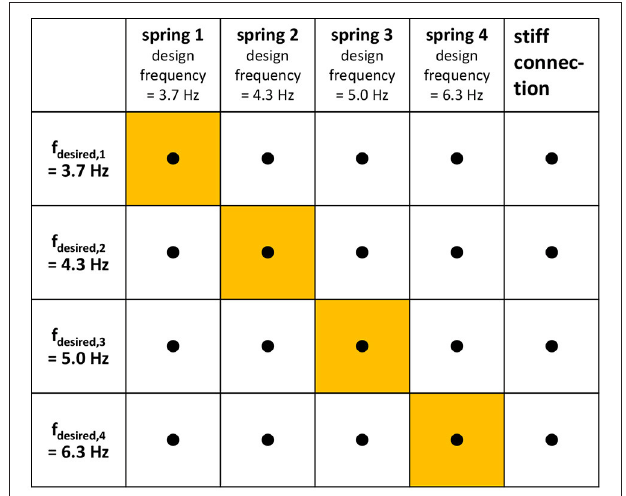
FIGURE 2 | Trials— Combination matrix of the factors “desired frequency” and “adapter type.” Each dot represents one trial, i.e., the subjects are asked to play all combinations. Note that the desired frequencies are chosen so that they correspond to the design frequencies of the four springs. The variable-stiffness strategy of this study, where the desired frequency is matched by the design frequency, corresponds to the highlighted diagonal of the